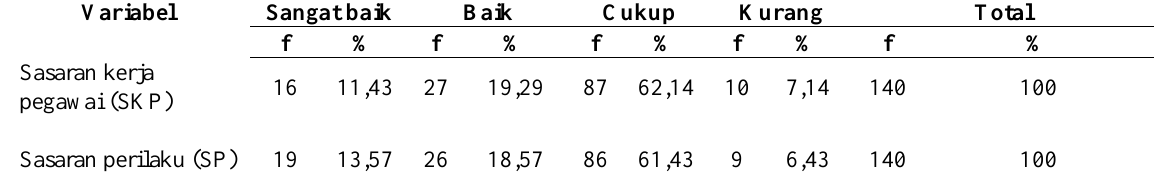
Tabel 1 menunjukkan distribusi frekuensi